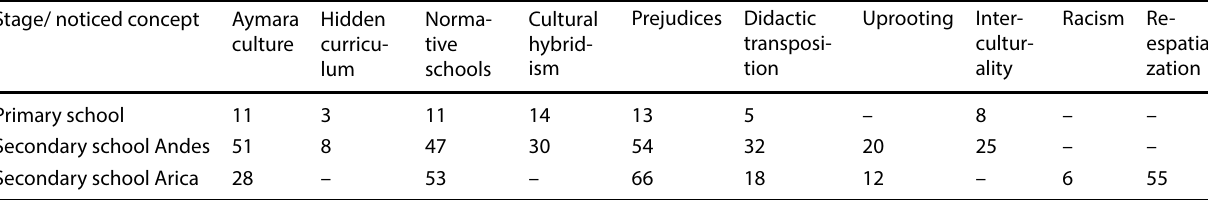
Source: Own elaboration,